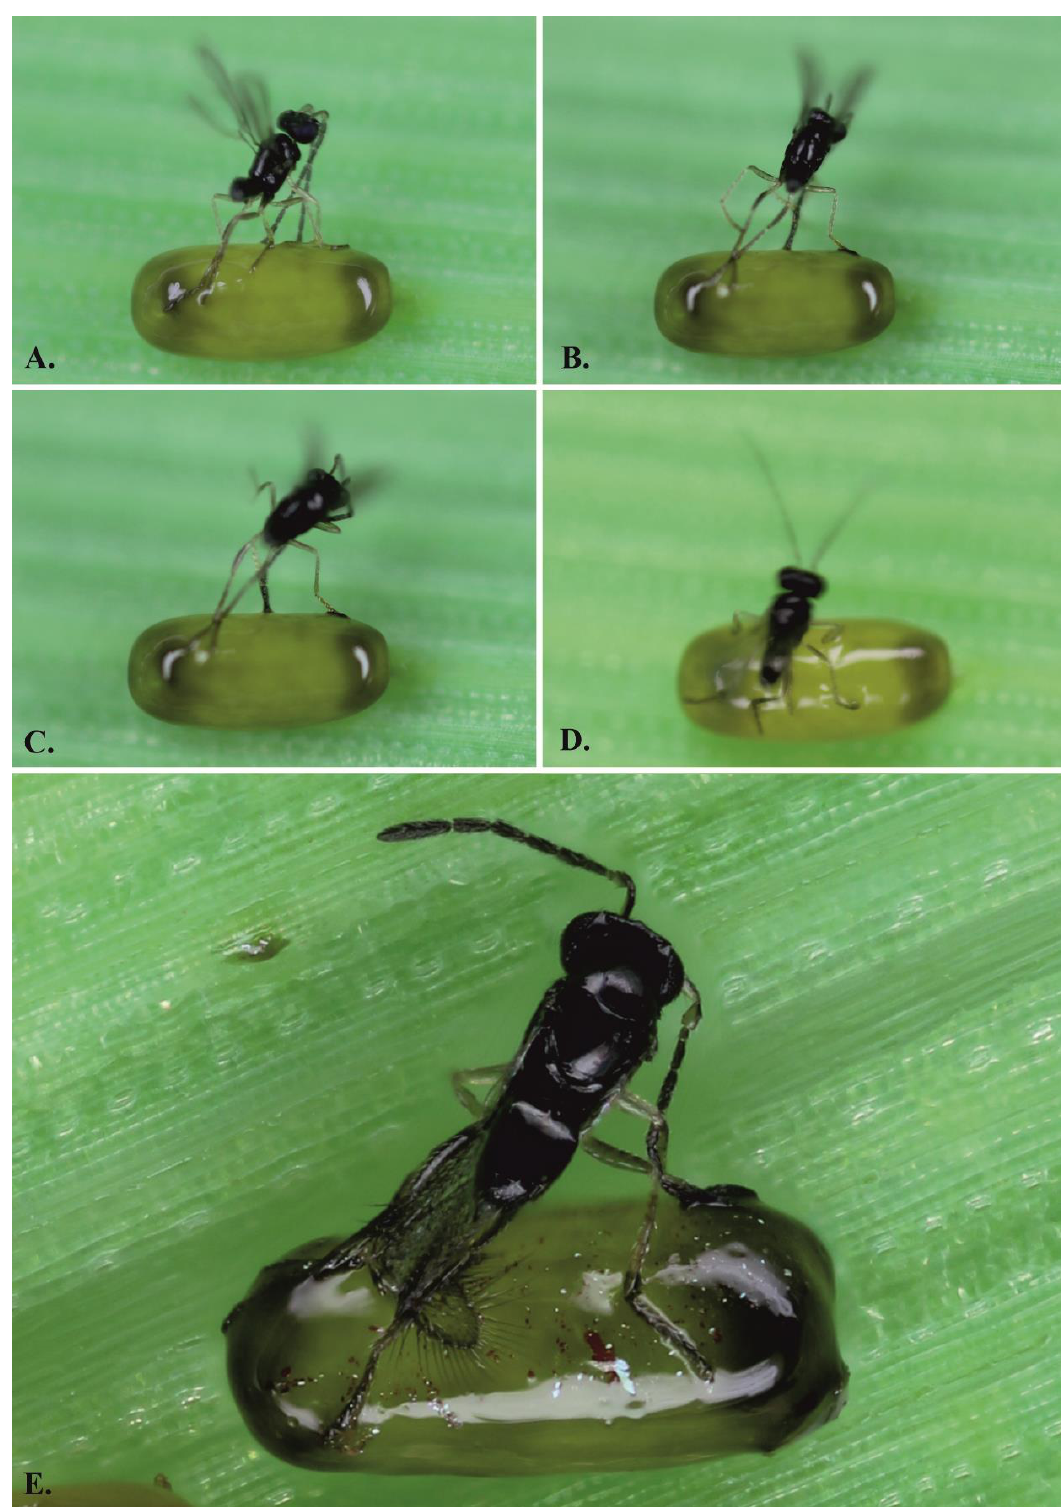
Figure 4. The parasitation on the host eggs with dark sticky layer by A. flavipes : ( A – C ) the dark sticky layer prevents the oviposition behavior of A. flavipes ; ( D,E ) the wasps are unable to overcome the sticky layer of the host eggs.